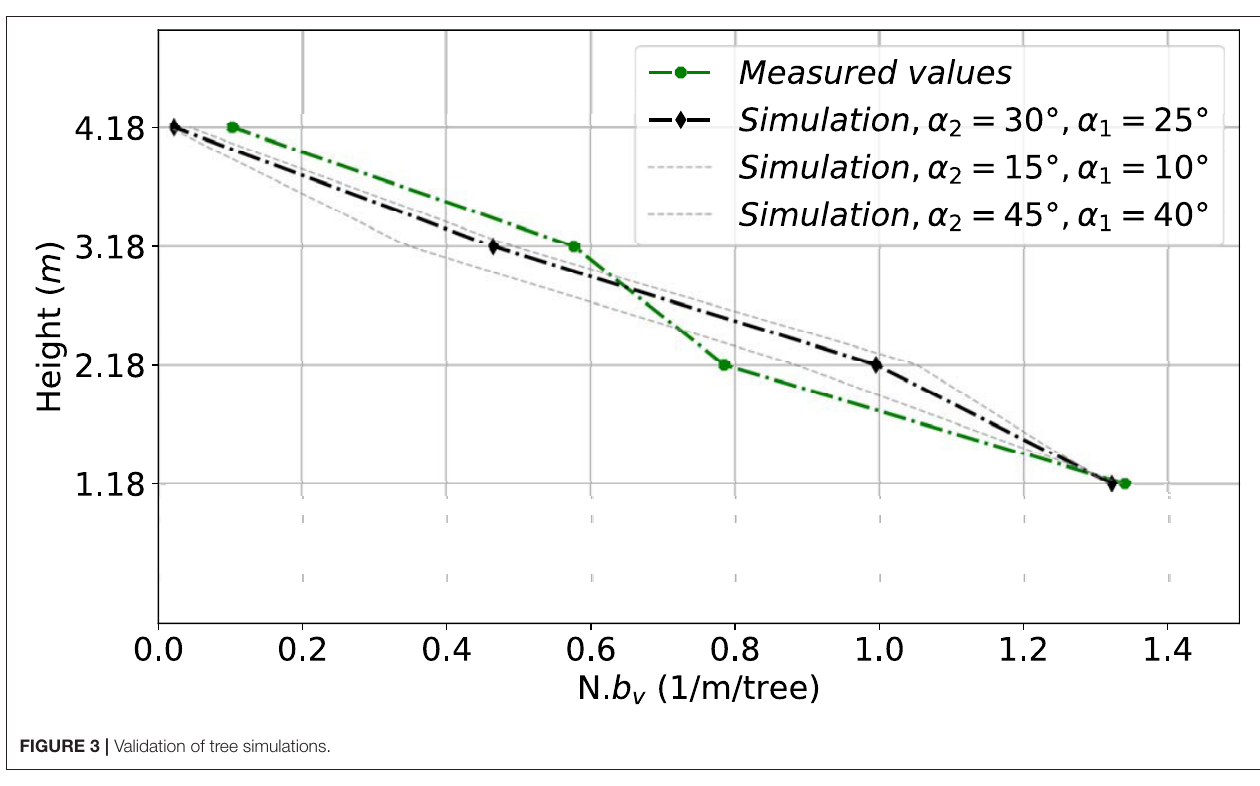
FIGURE 3 | Validation of tree simulations.